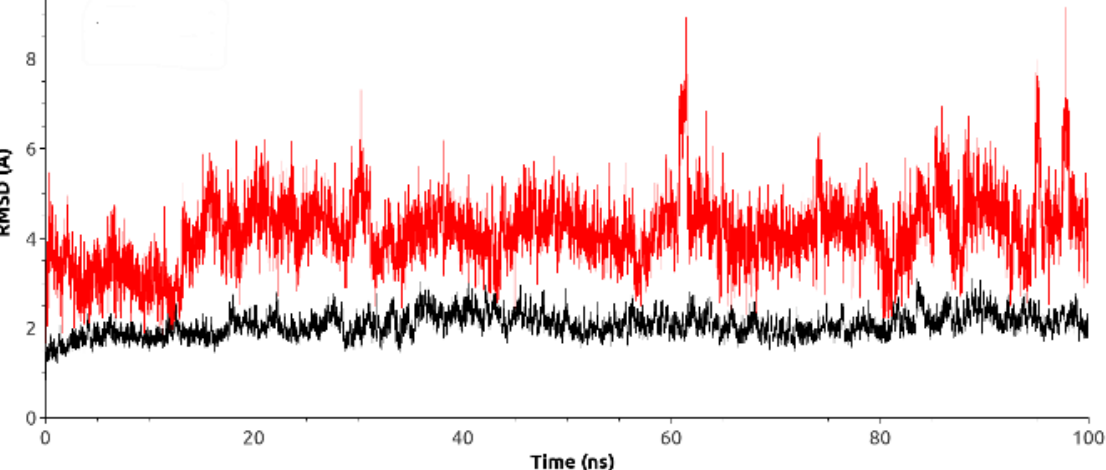
Figure 8. Root-mean-square deviation (RMSD) during molecular dynamics simulation of telomerase (red) in complex with compound 36b (black).